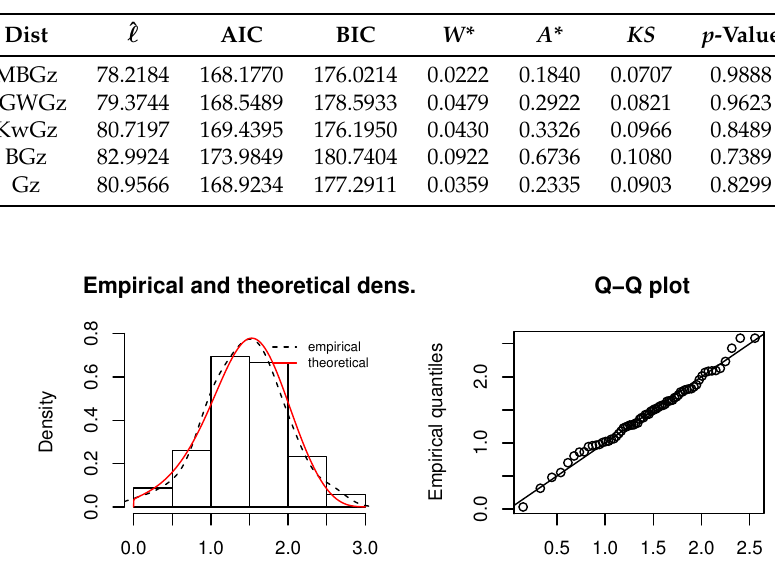
Table 5. The AIC, BIC, W* , A* , KS , and p -Value values for Dataset 2.